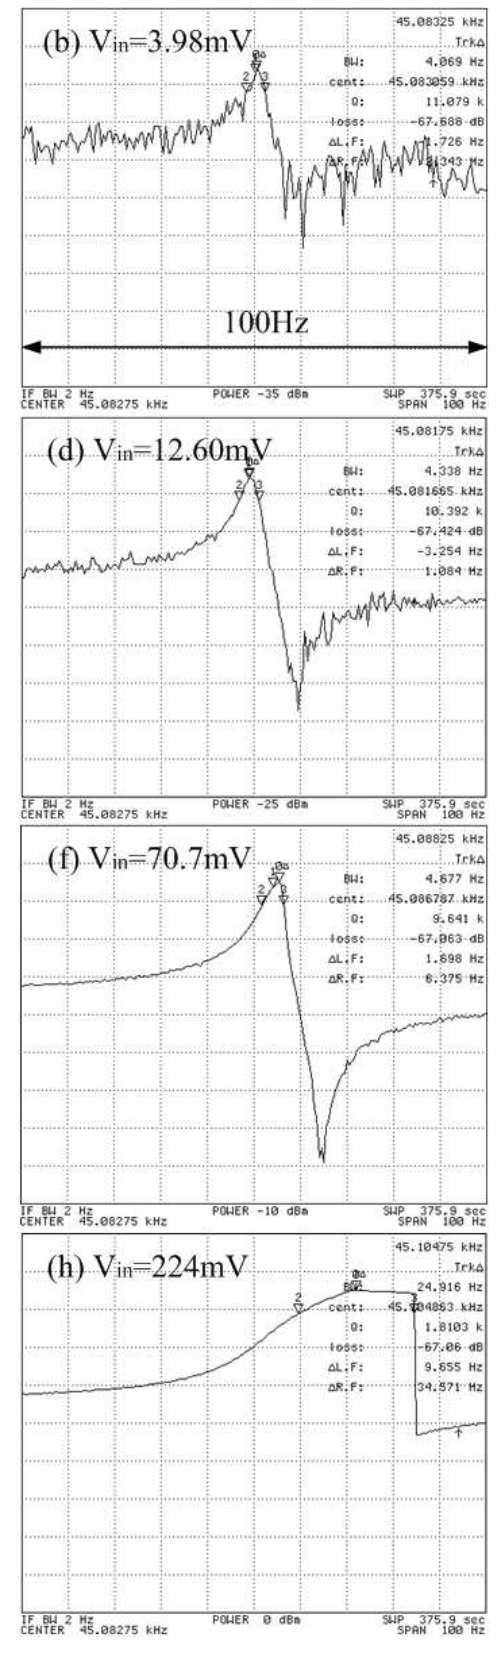
1 for varied driving voltages f